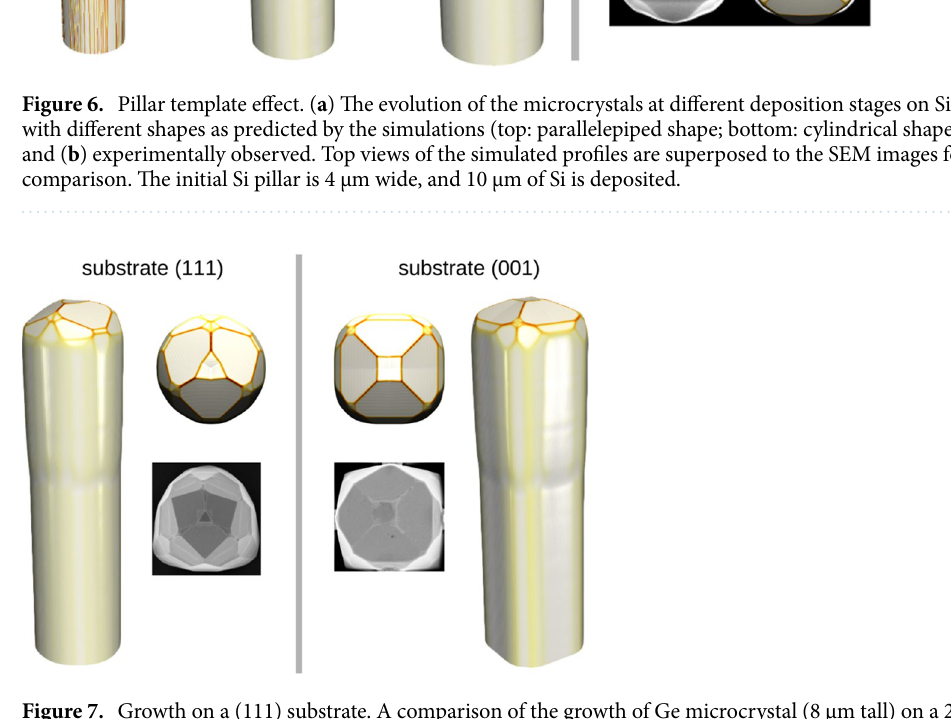
Figure 7. Growth on a (111) substrate. A comparison of the growth of Ge microcrystal (8 μm tall) on a 2 μm wide Si pillar on the (111) (left, circular Si pillar) and (001) (right, square Si pillar)